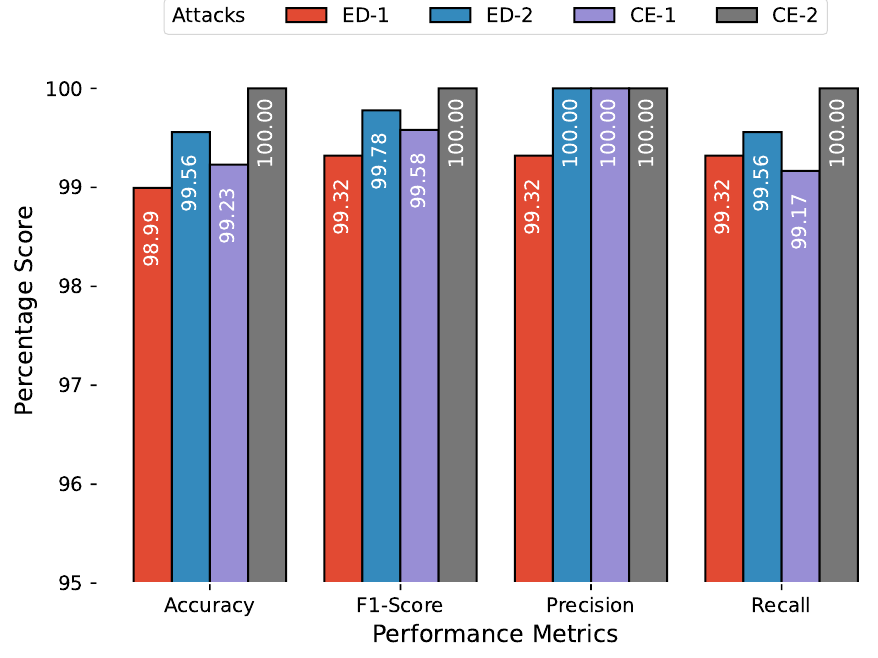
Figure 10. Anomaly detection results of PiData dataset, the attack abbreviations are; ED: emulated DoS, CE: code execution.